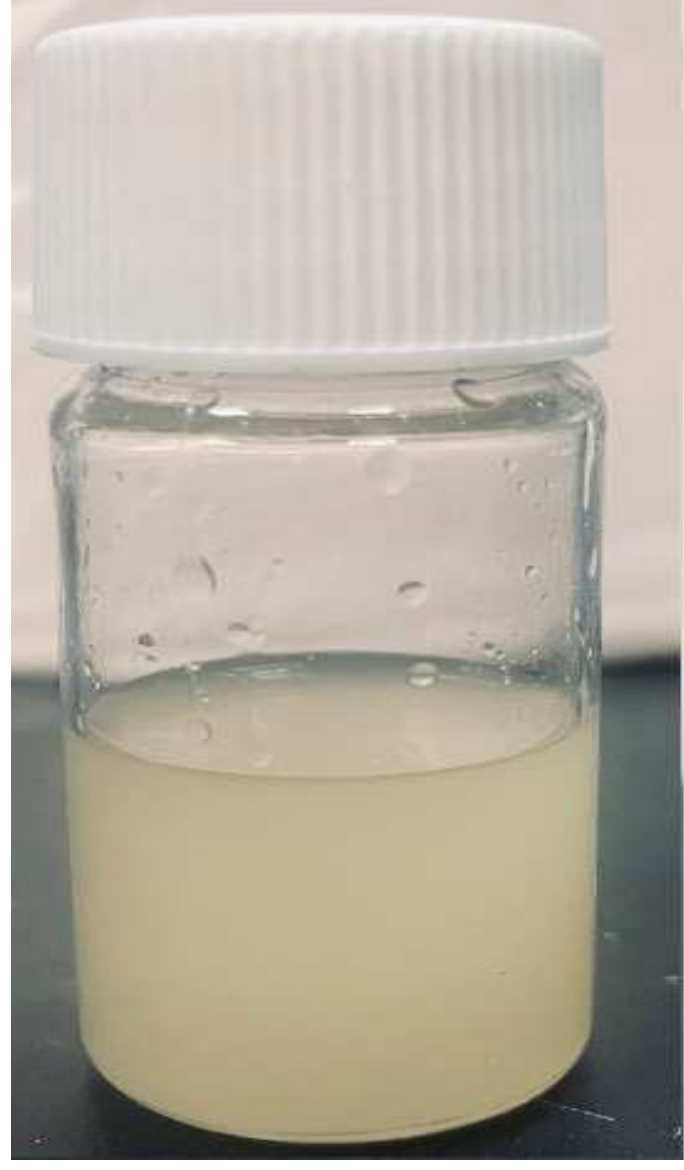
Figure 10. Developed CRB-NE1 loaded chitosan gels.